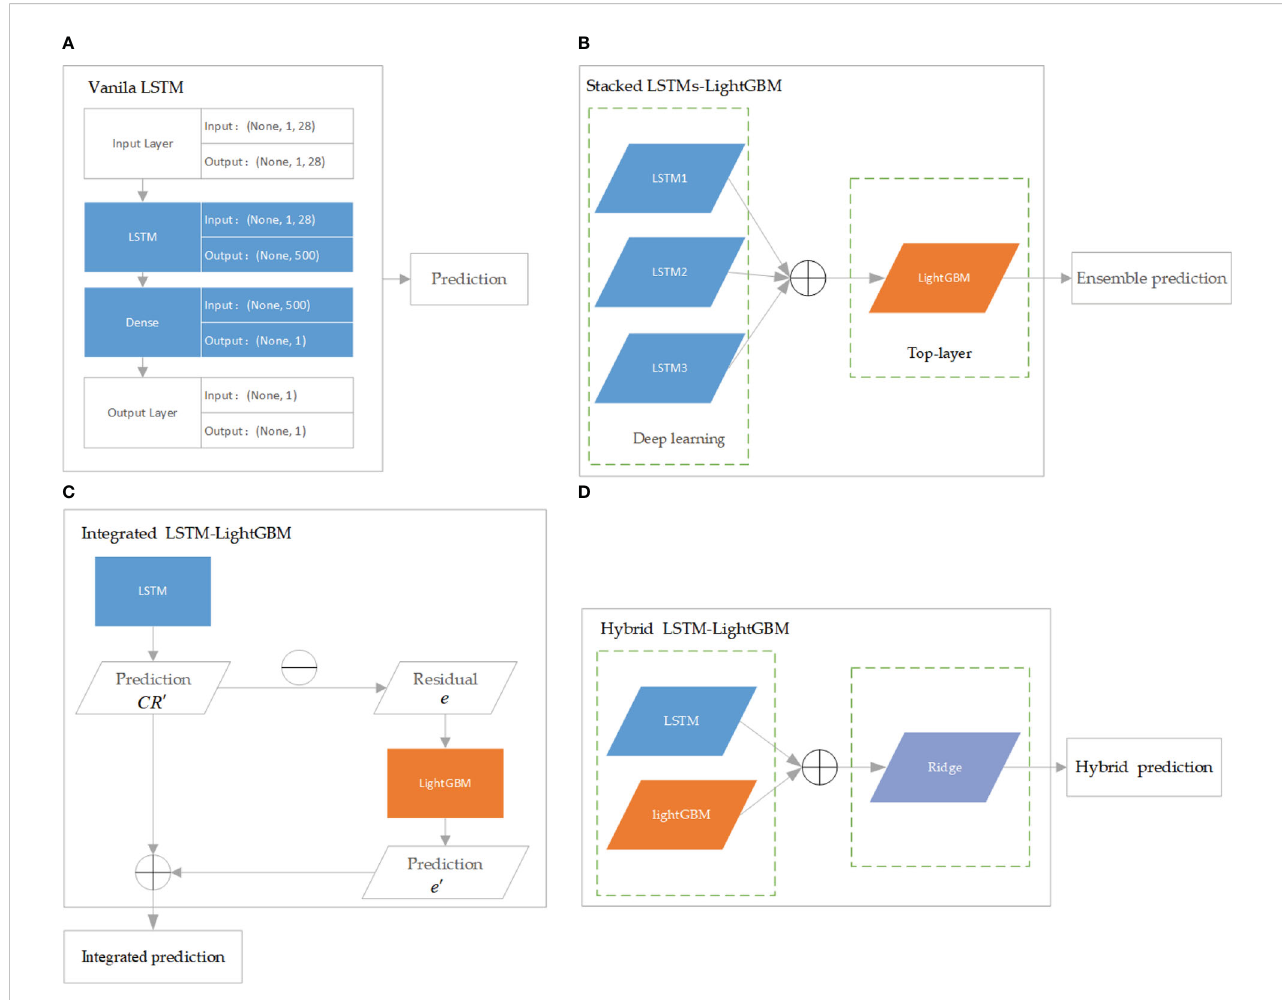
FIGURE 3 The architecture of LSTM and its variant algorithms. (A) is Vanila LSTM algorithm; (B) is Stacked LSTMs-LightGBM algorithm; (C) is Integrated LSTM- LightGBM algorithm; (D) is Hybrid LSTM-LightGBM